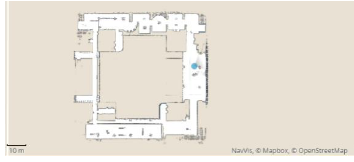
Figure 6.Cloud map after